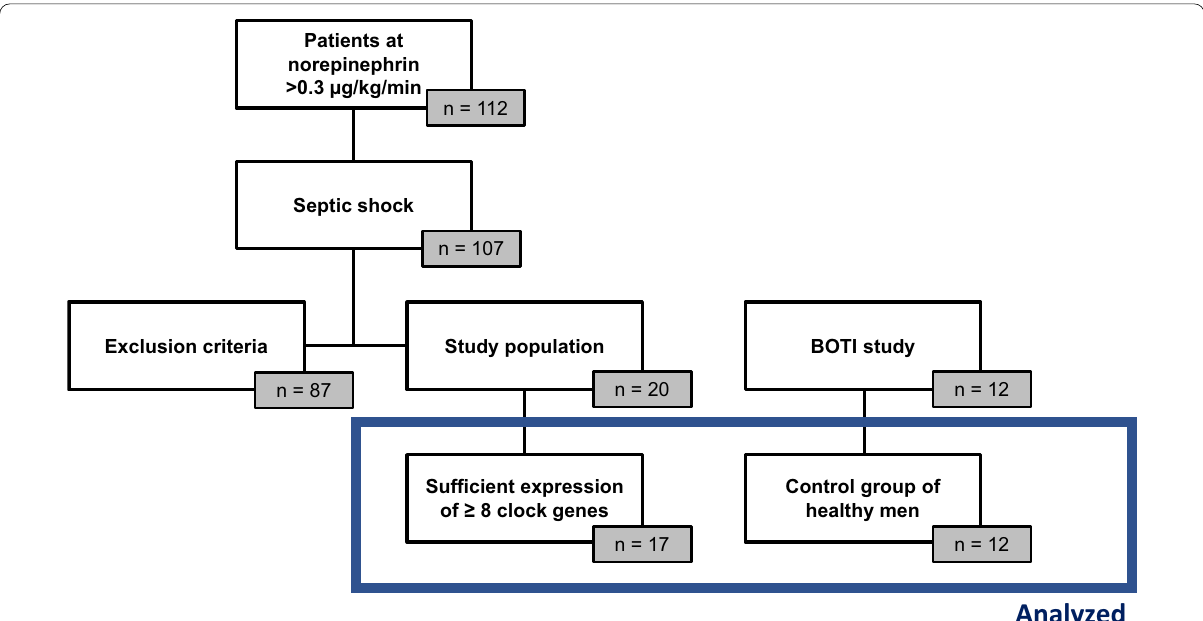
Fig. 2 CONSORT diagram, 17 patients were included to the final